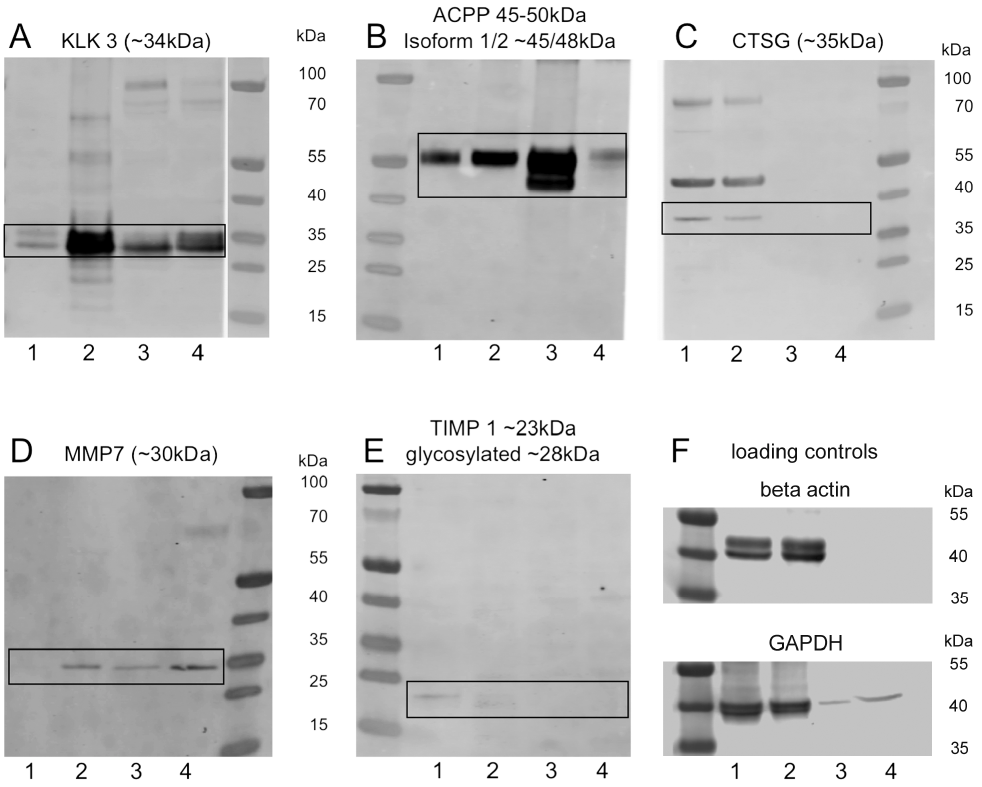
Figure 2. Western blot analysis of prostate and seminal plasma. KLK3 and ACPP were detected in high abundance in prostate tissue ( lanes 1 , 2 ) and seminal plasma ( lanes 3 , 4 ) at the predicted molecular weight of 34 and 50 kDa, respectively ( A , B ); occasionally multiple banding indicated isoforms or post-translational modification (glycosylation); CTSG was detected exclusively in prostate tissue showing three to four distinct bands at ~35, ~45; ~60 and ~80 kDa ( C ); MMP7 could be detected in prostate tissue and seminal plasma at ~30 kDa ( D ) and we found very low levels of TIMP1 ( E ). MMP14, MMP3, TIMP2 and CMA1 were negative in all examined samples (data not shown; n = 4 prostate; n = 6 seminal plasma); ( F ) loading controls; note negative staining for β actin in seminal.